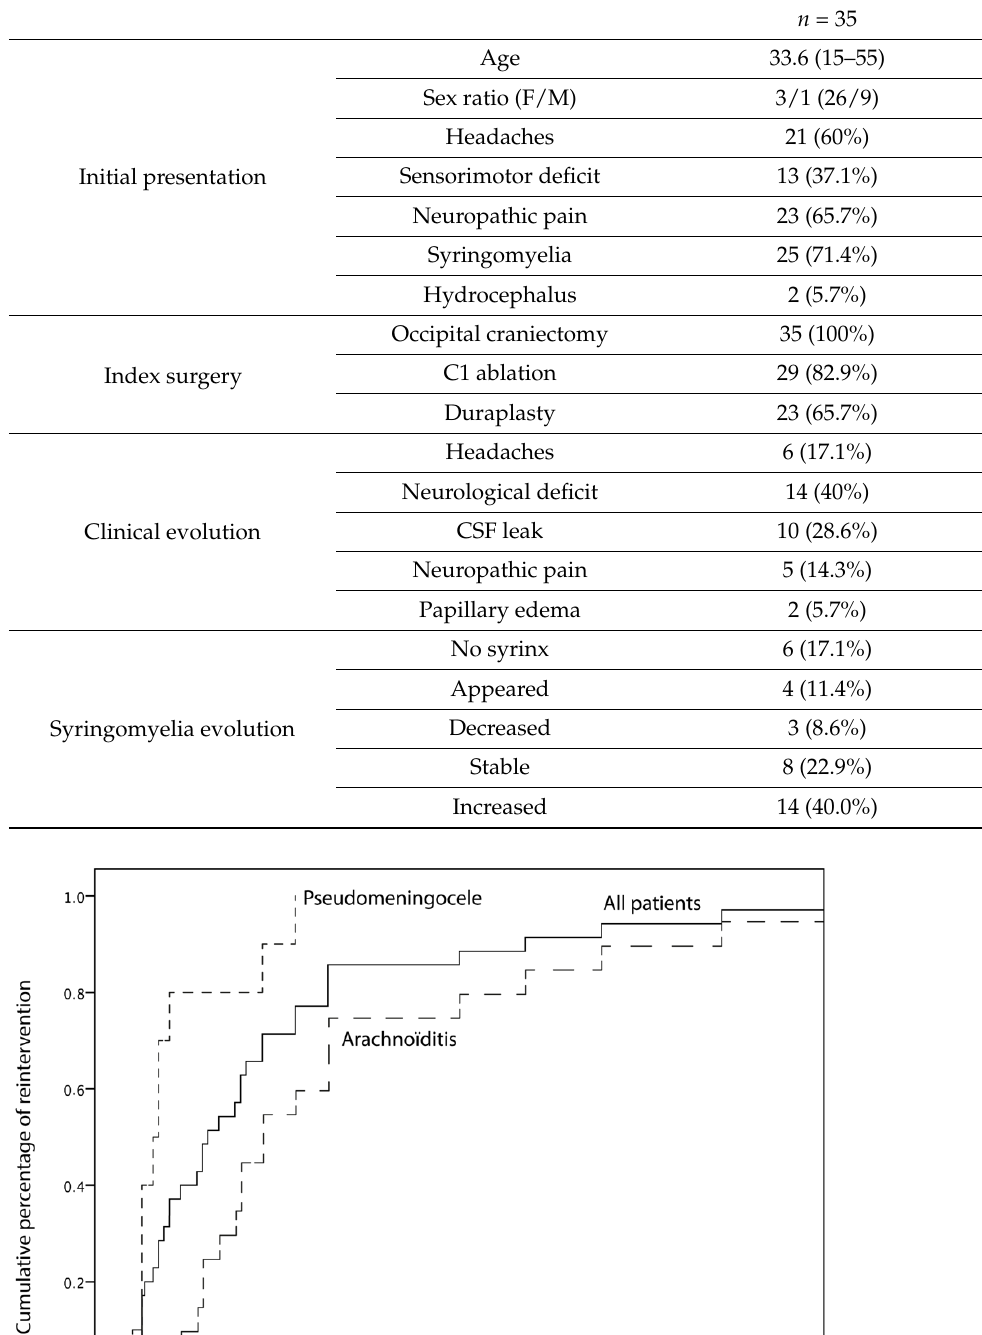
Table 1. Index surgery: presentation and outcome.